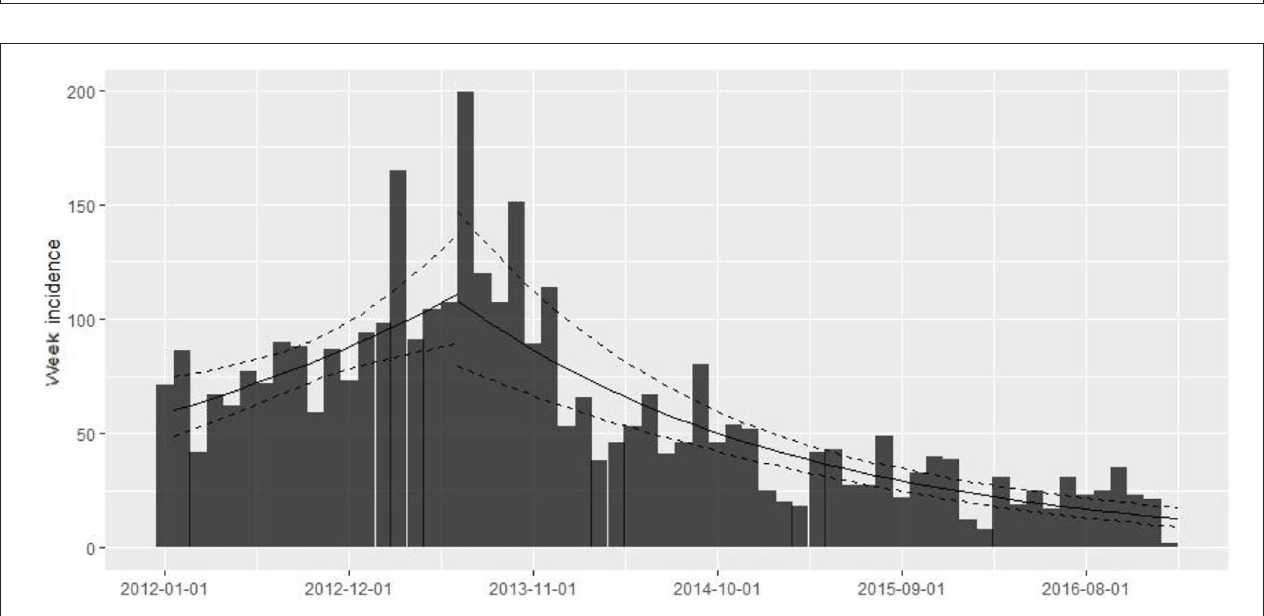
FIGURE 3 | Caligus rogercresseyi growth rate during 2012–2016 in southern Chile (weekly number of new farms as abundance > 3 by study period/the sum of the weeks where farms were active in the study period as a time at risk) using a simple log-linear regression model where the growth rate ( r ) is the slope of the regression form log( y ) = r × t + b . The rising trend line shows the growth rate before the 2013 peak (0.001 per farm-year at risk) and the descending trend line shows the growth rate after the peak ( − 0.004 per farm-year at risk).